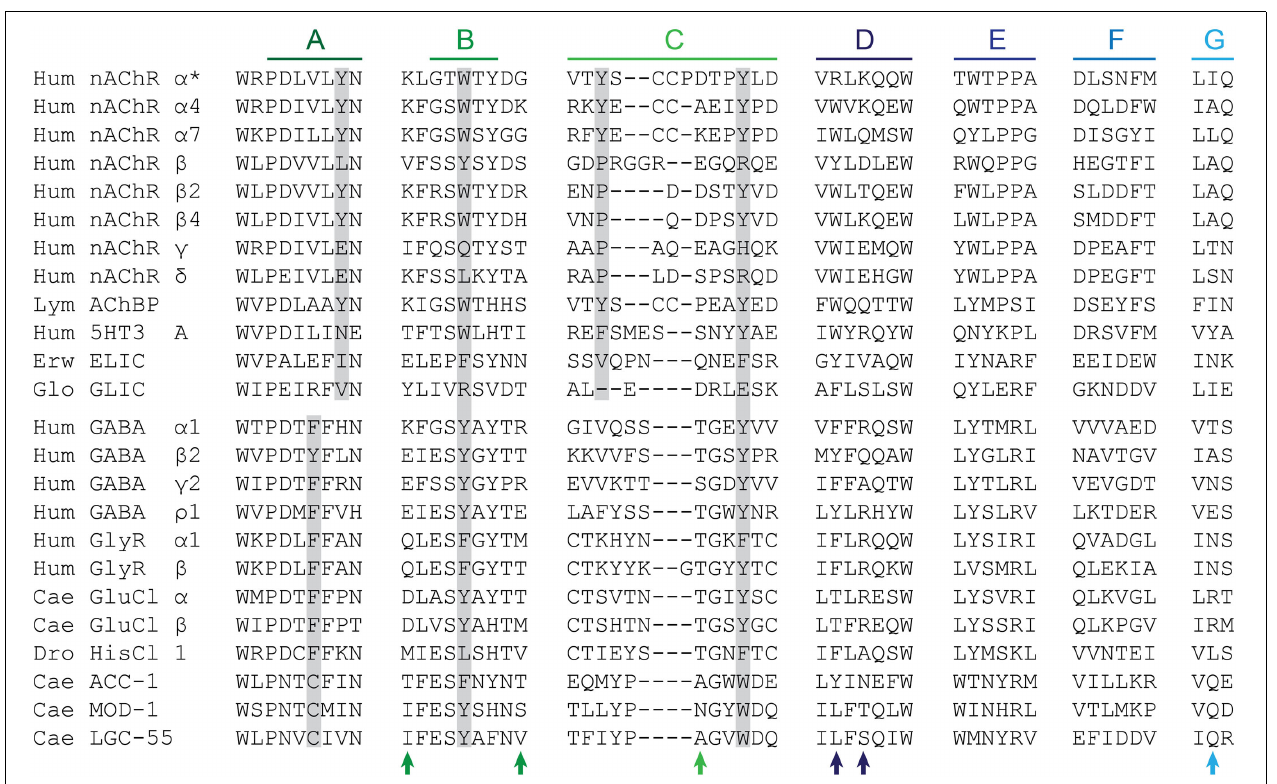
FIGURE 3 | Amino acid sequence alignment. Only side chains in agonist-binding loops are shown, plus small segments abutting Loop A and Loop B. Hum , human; Lym , Lymnaea stagnalis ; Erw , Erwinia chrysanthemi ; Glo, Gloeobacter violaceus ; Cae , Caenorhabditis elegans ; Dro , Drosophila melanogaster . ∗ Refers to nAChR isoform 1, which is up-regulated in muscle but less abundant in humans than isoform 2, which contains a 25 amino acid insert in Loop D (Beeson et al., 1990; Talib et al., 1993). While ELIC gates in response to primary amines, GLIC is a proton-gated cation channel. HisCl 1 (Zheng et al., 2002), ACC-1 (Putrenko